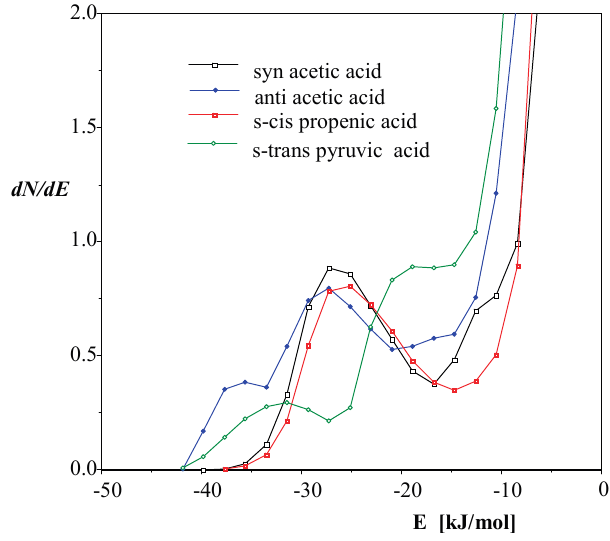
acetic acid (12 ); s-cis propenic acid ( 13 ); and s-trans pyruvic acid ( 14 ) with structures shown in Figure